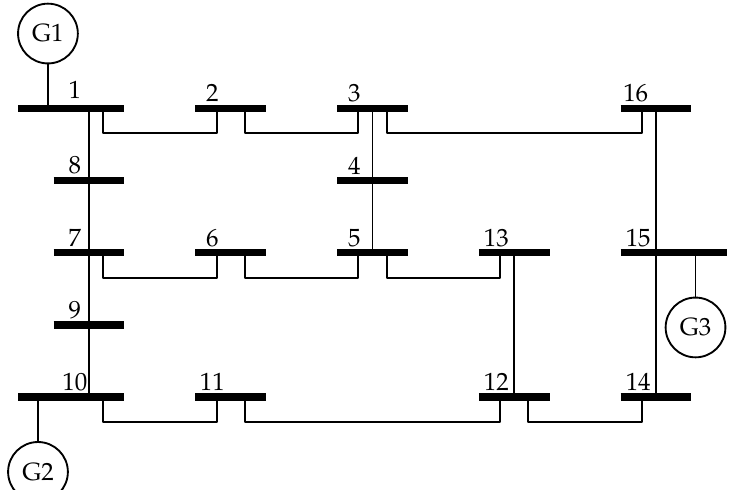
Figure 9. Diagram of the 16-bus system used in tests. Node 1 is a slack bus. Generators G2 and G3 represent a PV installation.